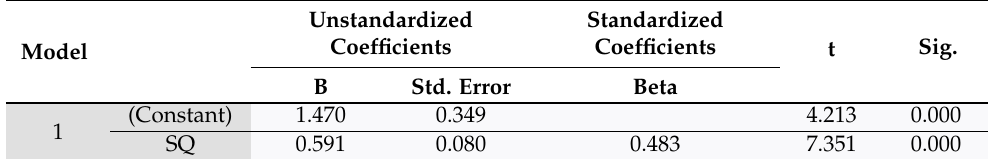
Table 5. Coefficients.